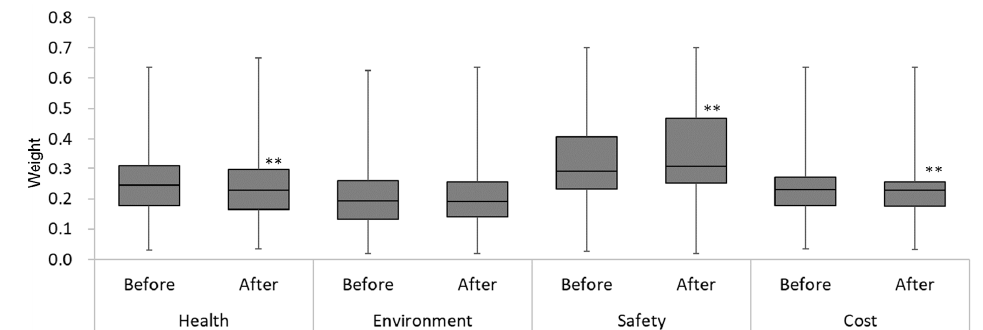
Figure 3. Weights of evaluation criteria (left: before watching video; right: after watching video). Two-sided test, alternative hypothesis: “before watching video” ≠ “after watching video”, ** p < 0.01. In the box plots, the boundary of the box closest to zero indicates the 25th percentile, the black line within the box marks the median, and the boundary of the box farthest from zero indicates the 75th percentile. Whiskers above and below the box indicate the 95th and 5th percentiles, respectively. The changes in the weights of the evaluation criteria after watching the video were almost the same for all subjects irrespective of knowledge about FRs and personal attributes. The weight for “Cost” allocated by male subjects decreased after watching the video (Figure 4). However, no significant difference after watching the video was observed in subjects younger than 30 years old to watching many videos on their personal computers, smartphones, and other devices.